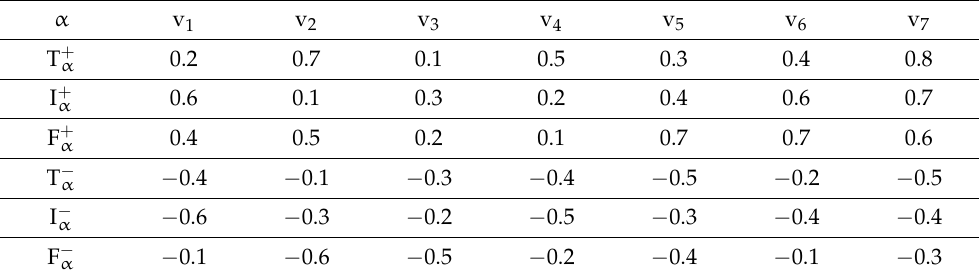
Table 6. Signless Laplacian energy of BSVNG set on V.